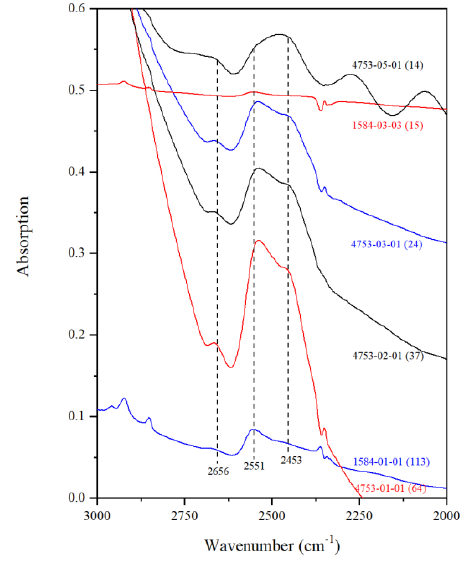
Figure 8. Thickness dependence of the absorptions of the IR peaks in the energy range ~3000–2000 cm − 1 . The IR spectra were taken from some thin sections made from high-H 2 O Mg-Rw (Run 4753) and low-H 2 O Mg-Rw (Run 1584). The IR # is followed by the measured thickness of the crystal plate ( D m in parentheses).